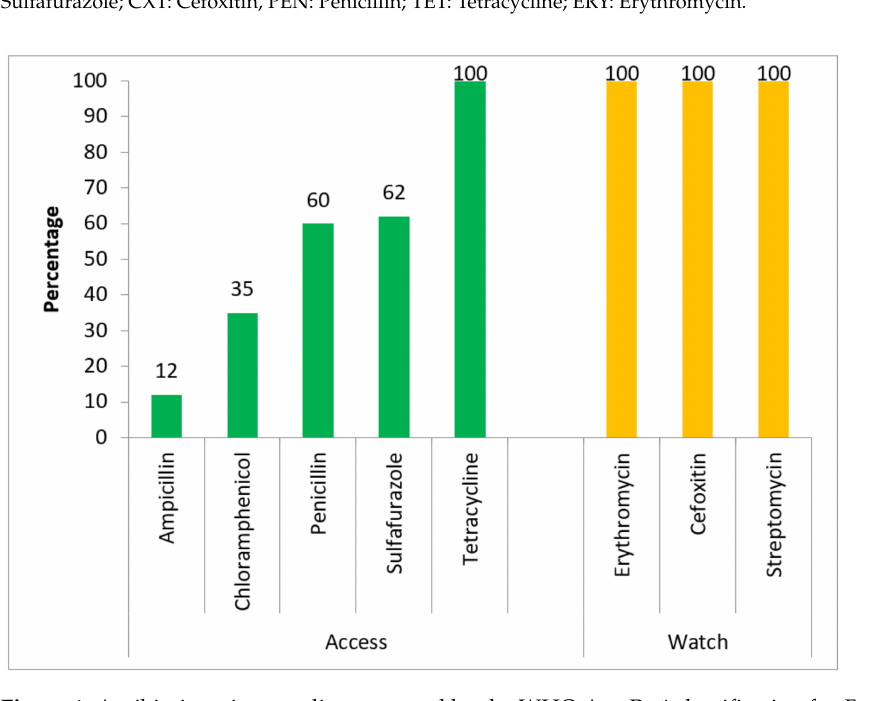
Figure 1. Antibiotic resistance disaggregated by the WHO AwaRe * classification for E. coli isolated from poultry excreta in Free Town, Sierra Leone 2021 (N = 93). * Access category : antibiotics